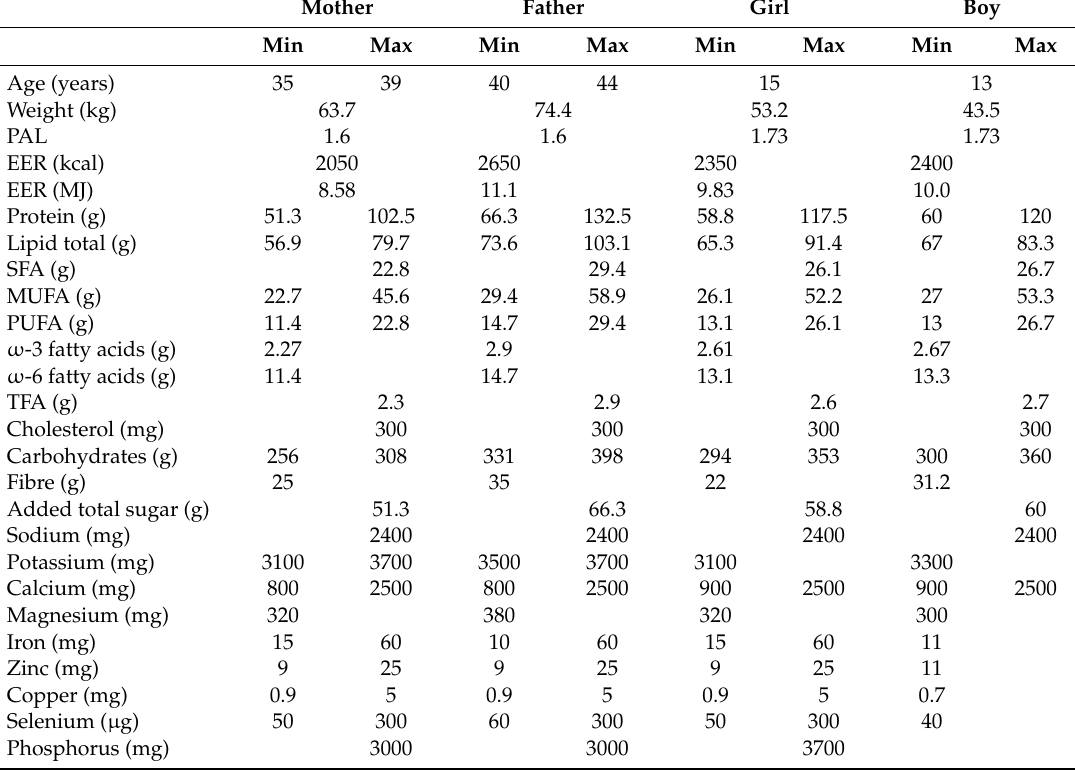
Table 1. Daily estimated energy requirements and recommended nutrient intakes for each member of the reference Estonian family of four